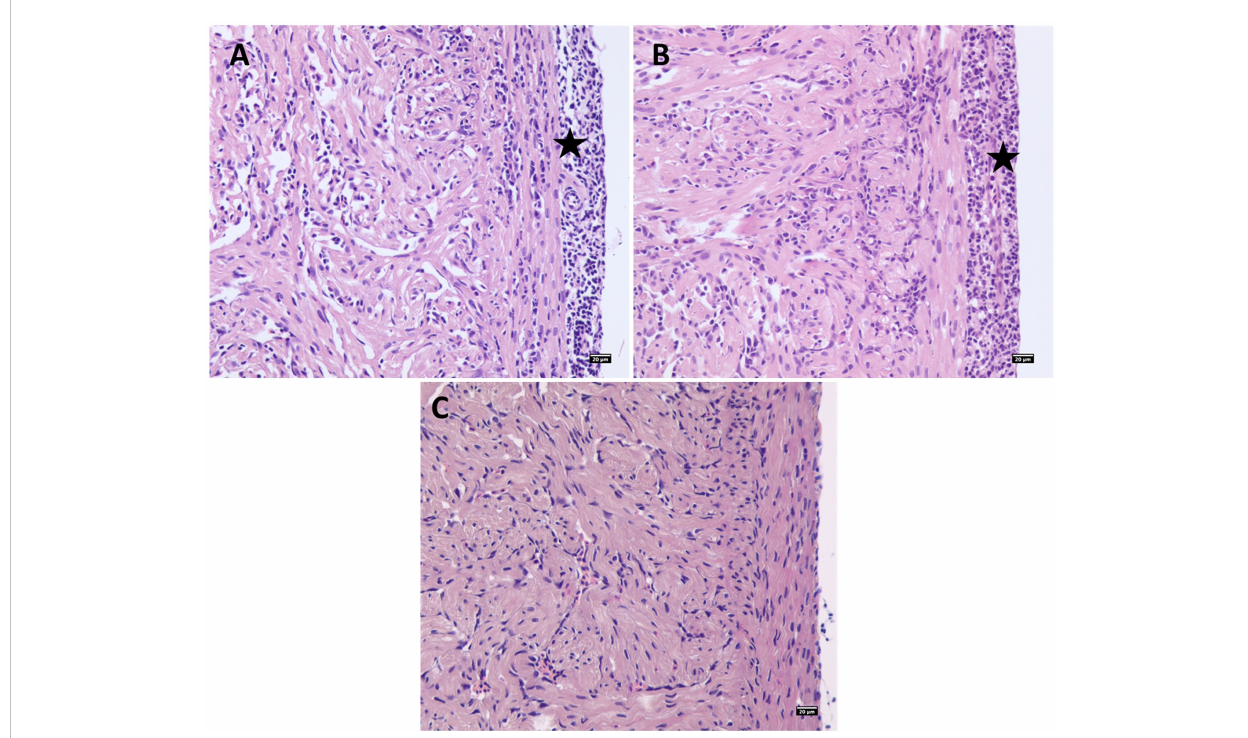
FIGURE 6 PRV-1 cohabitation challenged Atlantic salmon parr heart ventricle showing severe epicarditis and myocarditis in the compact and spongy myocardium at (A) 9 WPI and (B) 12 WPI. (C) Noninfected control salmon parr heart at 12 WPC. Stars highlight epicarditis.